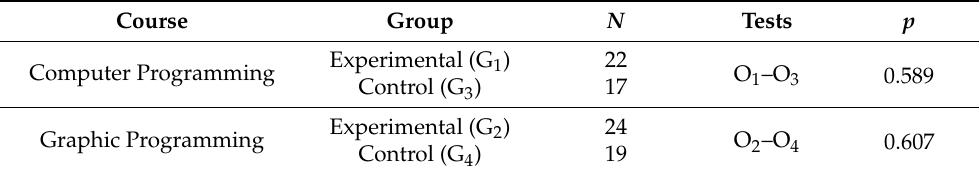
Table 13. Mann–Whitney U test for pre-tests.